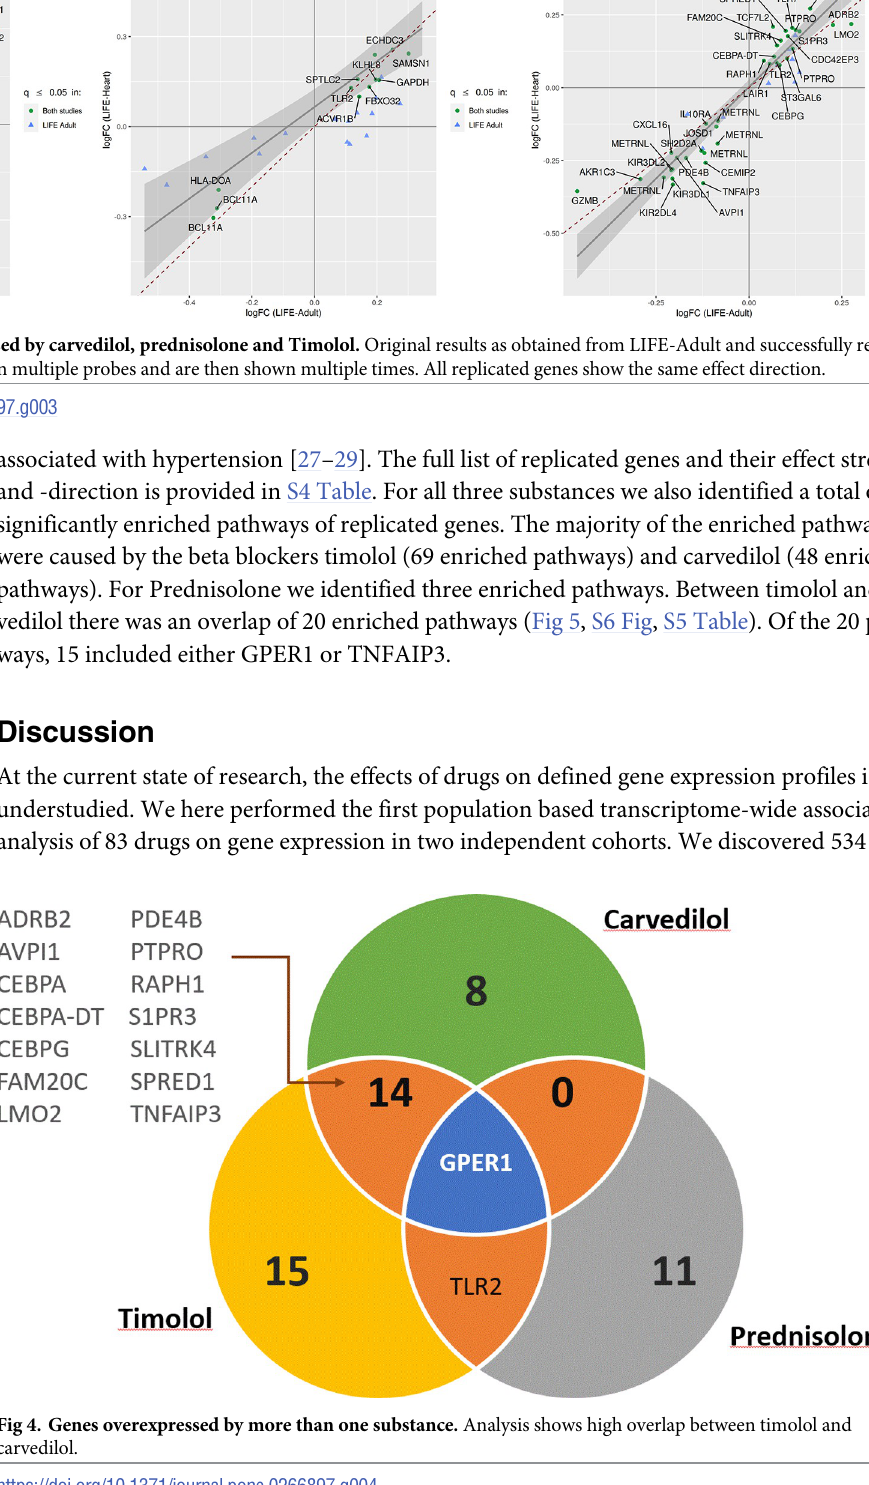
PLOS ONE | https://doi.org/10.1371/journal.pone.0266897 April 21,